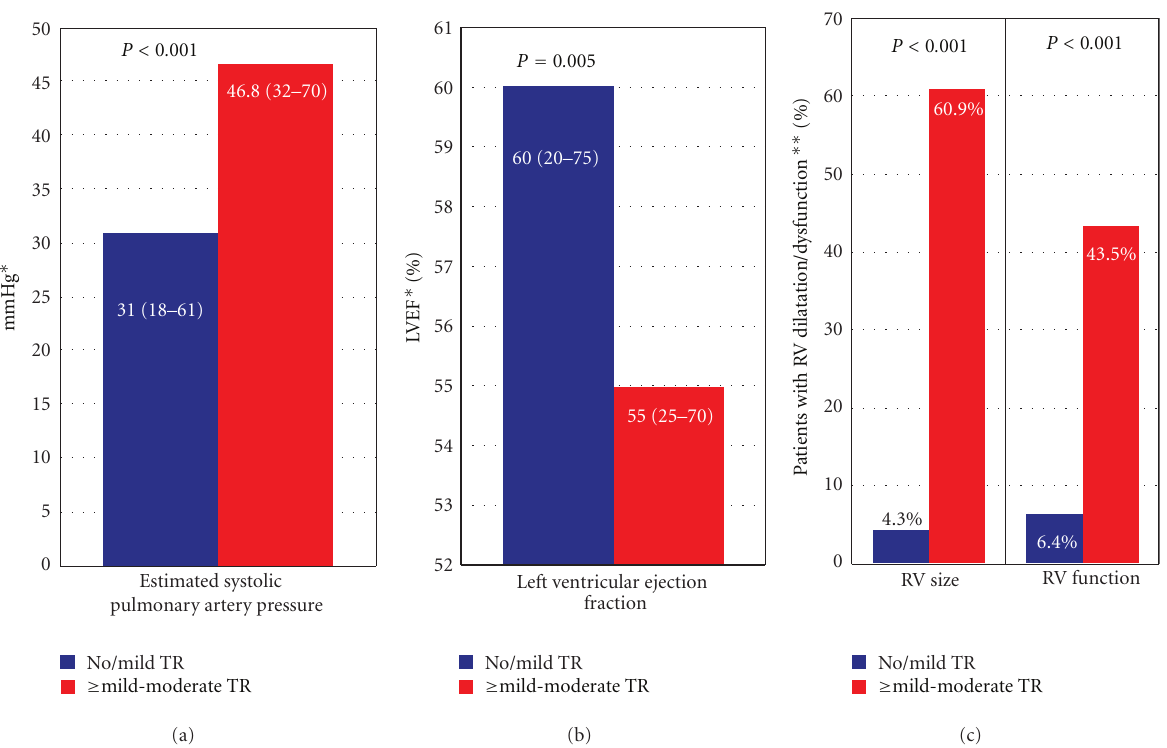
Figure 4: Relationship between late TR severity and echocardiographic parameters TR, tricuspid regurgitation; LVEF, left ventricular ejection fraction; RV, right ventricle. ∗ Data are presented as median and range (min–max). ∗∗ % Patients with right ventricular dilatation/dysfunction ≥